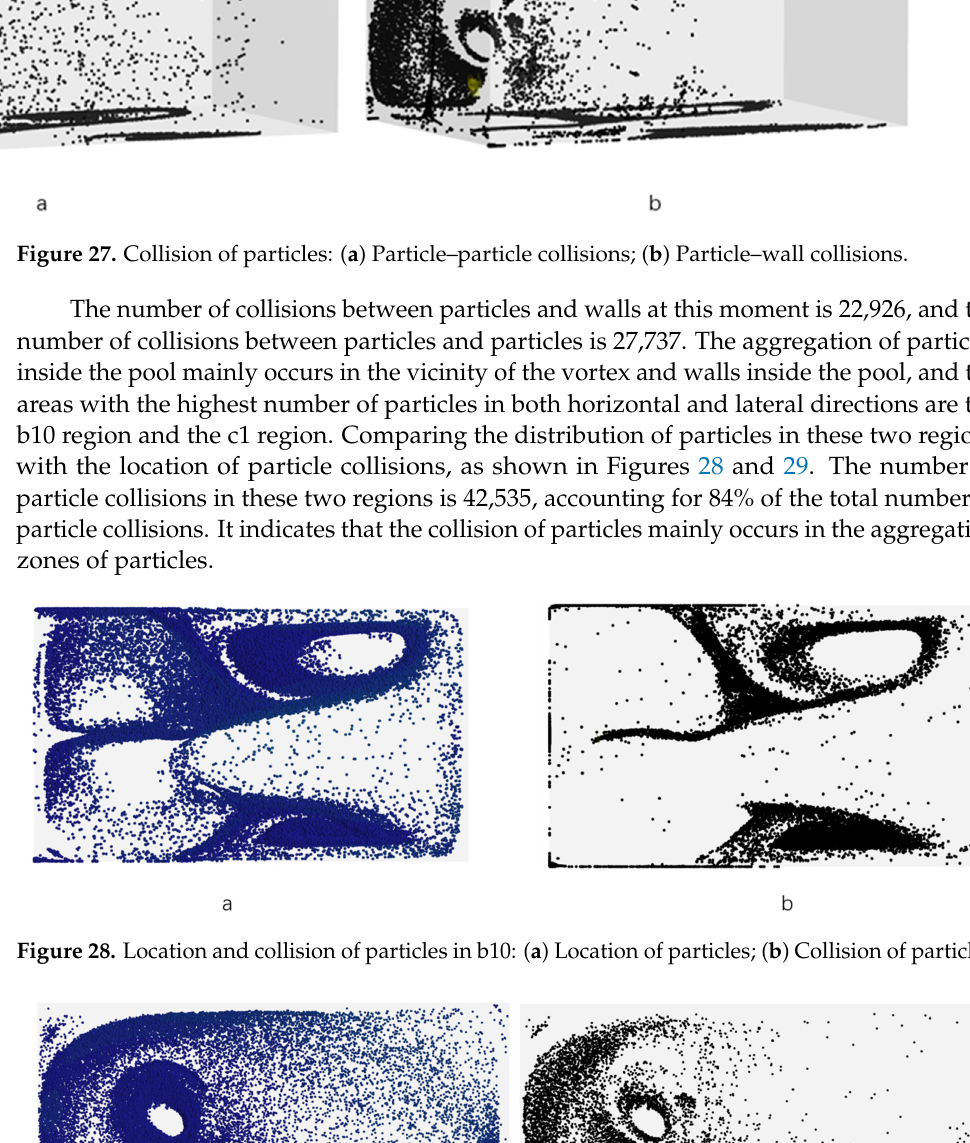
Figure 29. Location and collision of particles in c1: ( a ) Location of particles; ( b ) Collision of particles. 5. Conclusions In this paper, the solid–liquid two-phase flow field of the submersible mixer is stud- ied for the first time by using the coupled CFD-DEM method, and the motion character- istics and distribution law of particles inside the pool were analyzed from the scale of